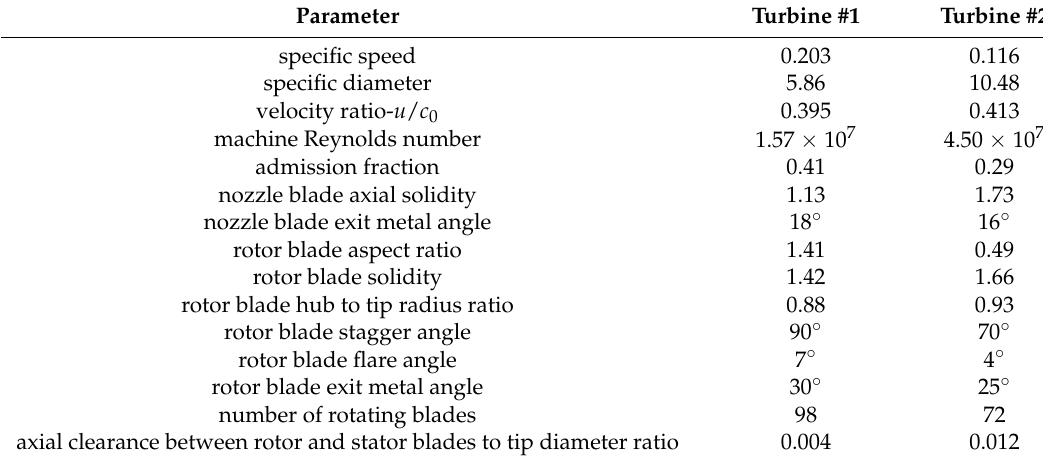
Table 3. Service conditions and non-dimensional geometric data for the two single-stage partial admission steam turbines tested at a factory bench.